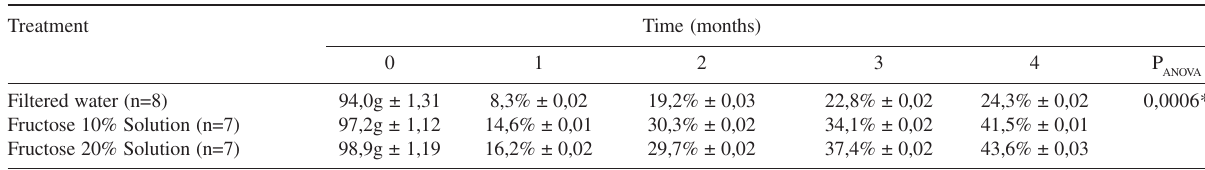
Table 2 - Variation of body weight (g) in animals treated for 4 months with filtered water, 10%, or 20% fructose solution and the standard laboratory diet. Results are expressed as mean ± SEM.